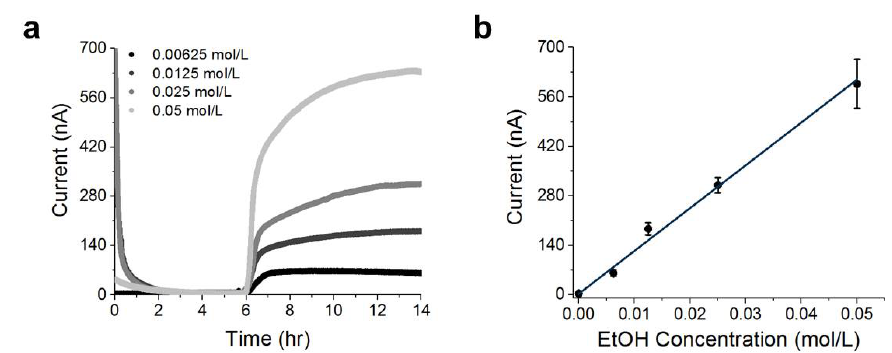
Figure 3. Laboratory characterization of the sensor